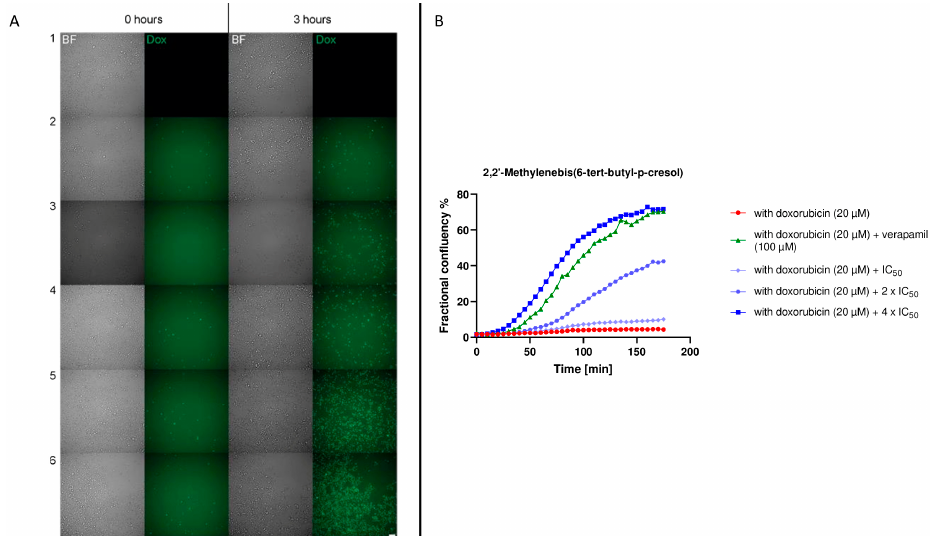
Figure 6 . Live cell time-lapse microscopy. ( A ) Snapshots of Brightfield channel (BF) and doxorubicin fluorescence (Dox) from the beginning (0 h) and at the end (3 h) for CEM/ADR5000 cells with different conditions (samples 1–6): (1) only medium; (2) + 20 µM doxorubicin; (3) + 20 µM doxorubicin + 100 µM verapamil; (4) + 20 µM doxorubicin + IC 50 compound 5; (5) + 20 µM doxorubicin + 2 × IC 50 compound 5 ; (6) + 20 µM doxorubicin + 4 × IC 50 compound 5. Scalebar: 20 µm. ( B ) Fractional confluence % in relation to time of compound 5 .